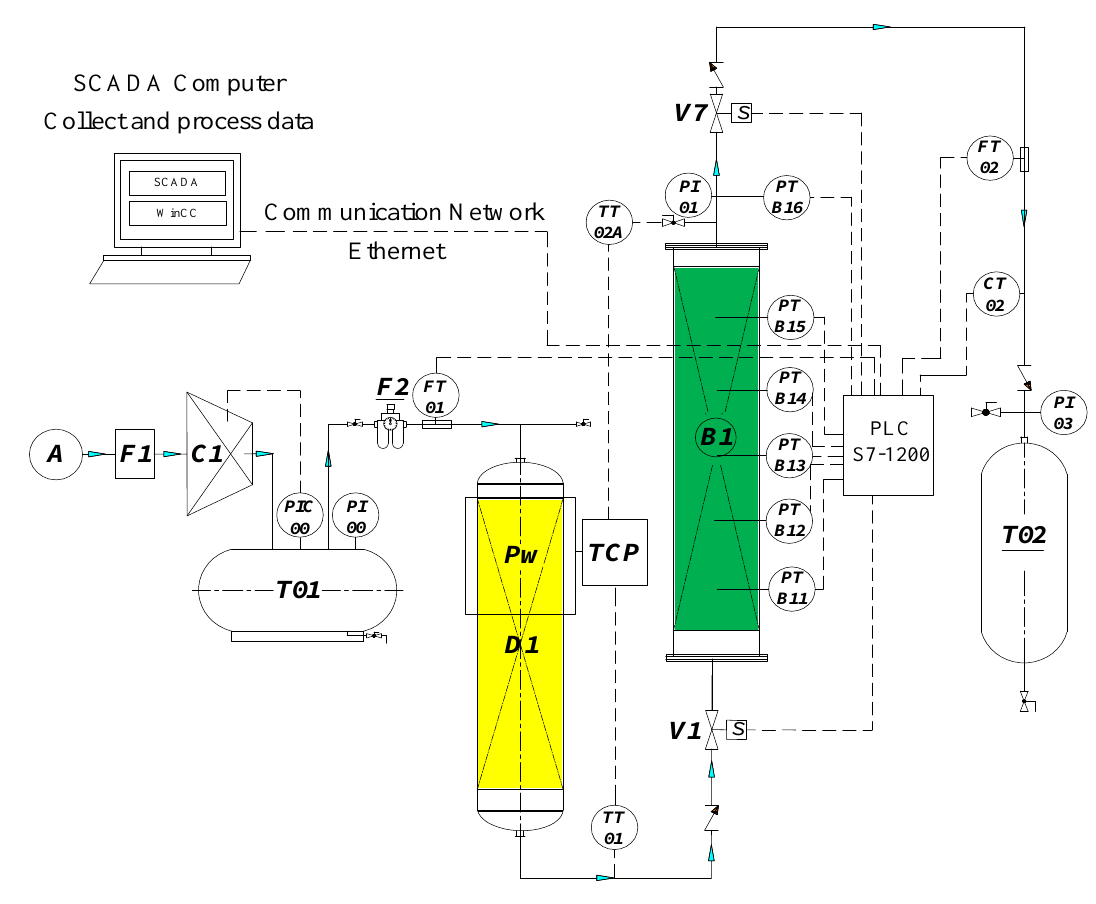
Figure 2. A single bed model.